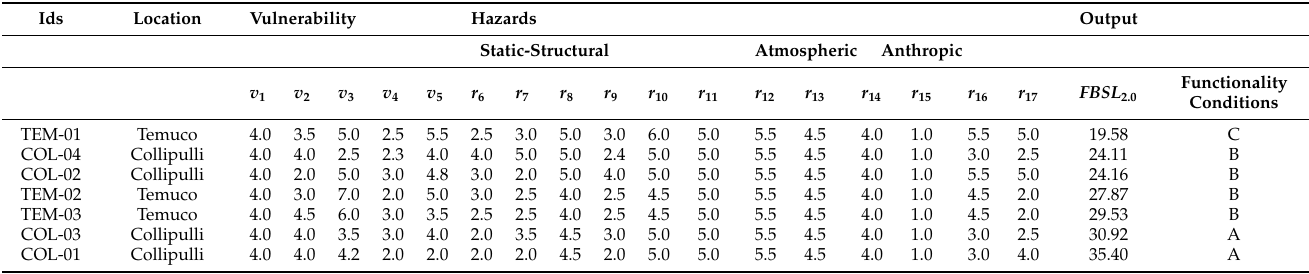
Table 7. Input variables and functional performances (outputs) for seven timber structures examined in the Araucan í a Region, southern Chile (climatic period